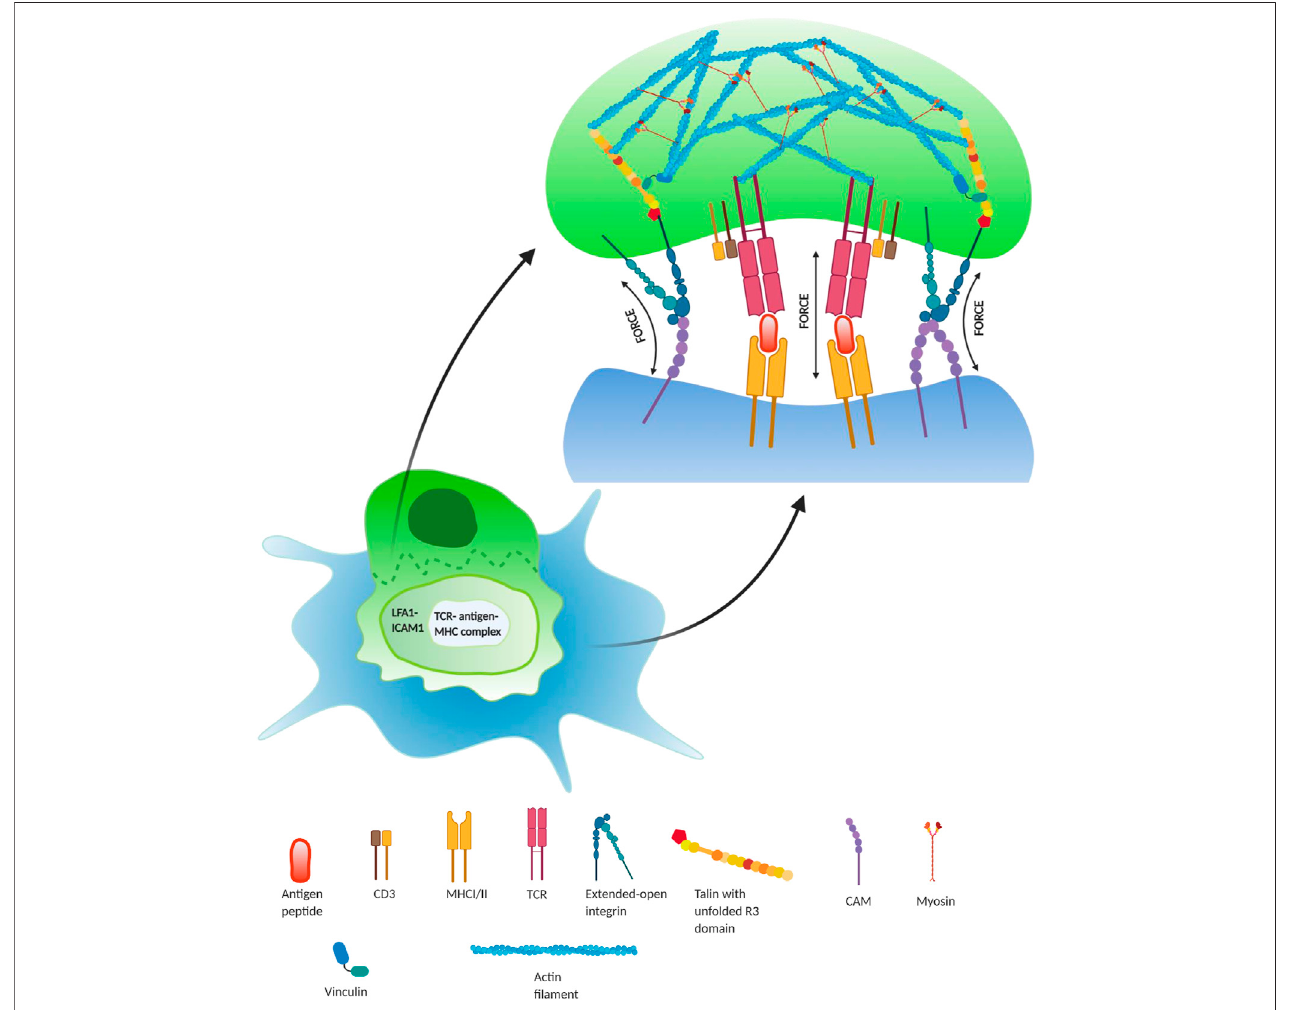
FIGURE 3 | Regulatory role of force during lymphocyte activation in immune synapse — during T lymphocyte activation (green), it interacts with an antigen- presenting cell (APC; blue) to recognize the antigen, presented by the APC. During this binding, there form three regions: central regions of supramolecular activation complex (cSMAC), peripheral SMAC (pSMAC), and distal SMAC (dSMAC). TCR/peptide – MHC interaction occurs in the cSMAC region and is required for the T-cell activation, whereas force-dependent integrin – ligand (LFA-1/ICAM1) interactions take place in the pSMAC region, which surrounds the inner cSMAC region. This resultsintheformationoffocaladhesioncomplexesinsidethelymphocyteattheimmunologicalsynapse.ThisintegrininteractionatthepSMACplaysacrucialroleinthe co-stimulation of T-cell activation by forming adhesome enriched with talin bounded actin – myosin complex. Additionally, the interaction between TCR-antigen – MHC complexes in the cSMAC also occurs under force and forms catch bonds up to ~10 pN (Huse, 2017).